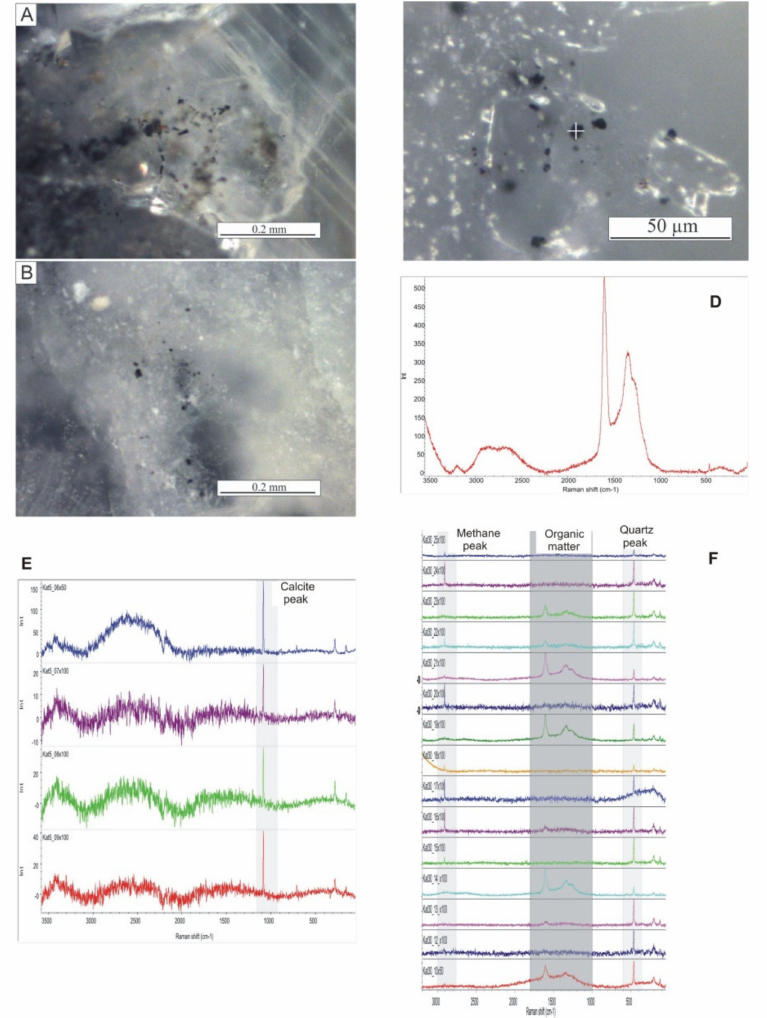
Figure 9. Photomicrographs and Raman spectra in the Katarzynin 2 borehole. ( A – C ) Fluid and solid inclusions in minerals. ( D – F ) Raman spectra showing calcite and quartz peaks together with organic